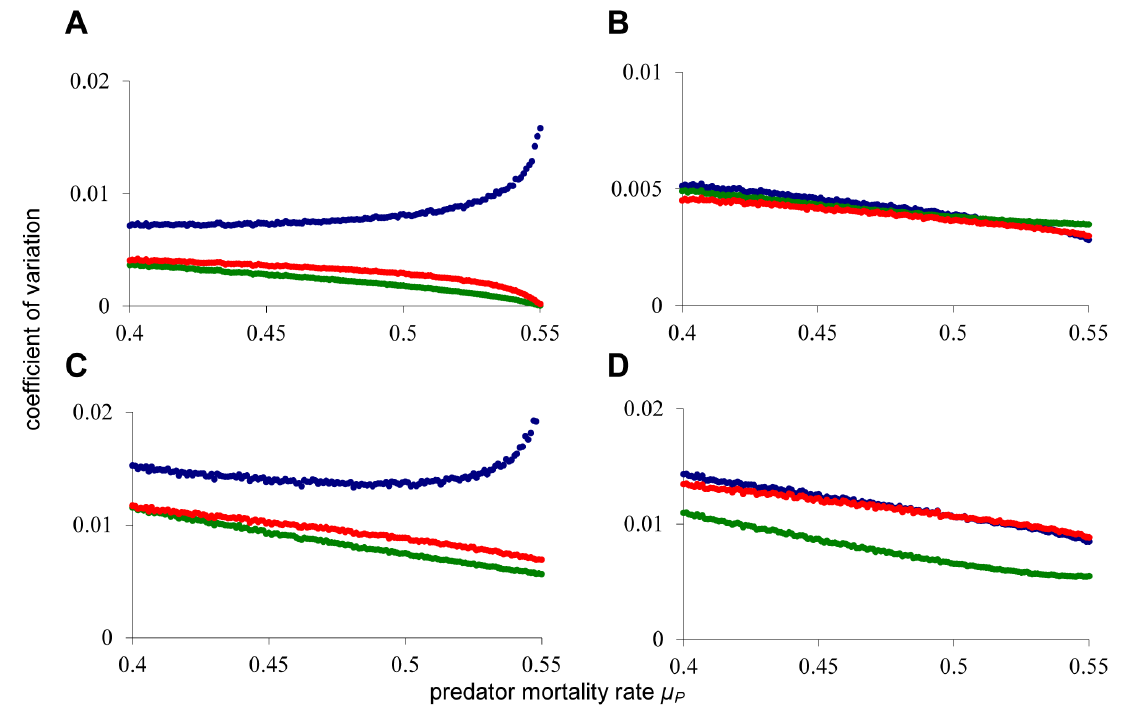
Figure 2. Early warning signals in coefficient of variation. For each value of m P , starting with m P =0.4, the model is simulated for 60,000 time units, of which the last 50,000 time units are used to compute population averages and variances. Hereafter, m P is incremented with D m P =0.001, towards the catastrophic collapse at m P < 0.553. Death rates are perturbed every time unit using white noise with standard deviation s =0.005. ( A ) Noise added to the juvenile population ( B ) Noise added to the adult population ( C ). Independent noise added to all three populations. ( D ) Identical, fully correlated, noise added to all three populations. Colors are blue for juveniles, green for adults, and red for the predators. For other model parameters see Figure 1.